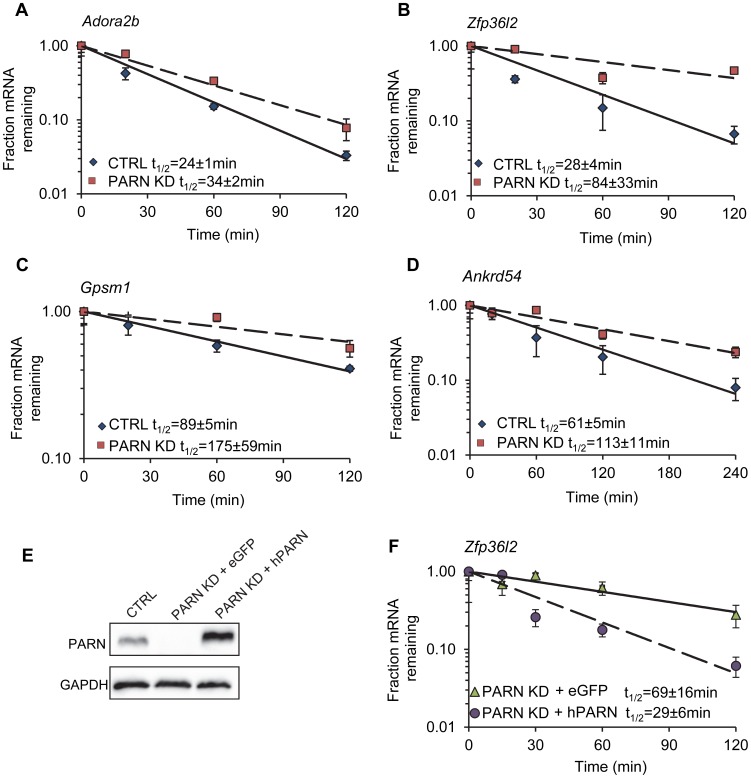
Independent assays validate the changes in decay in PARN KD cells and verify that stabilization is due to PARN depletion.mRNA decay rates for (A) Adora2b, (B) Zfp36l2, (C) Gpsm1 and (D) Ankrd54 were determined following Act-D treatment. mRNA abundance at each time point was assessed by qRT-PCR and normalized to that of Gapdh as a stable reference gene. Error bars represent the standard deviation derived from three independent experiments. Half-lives are reported with the standard error at 95% confidence intervals. (E) PARN KD cells were transfected with a control vector (eGFP) or with a construct encoding human PARN and PARN expression was verified by western blot using anti-PARN antibody with GAPDH as a loading control. (F) mRNA decay rates for Zfp36l2 mRNA were evaluated by qRT-PCR in PARN KD cells expressing eGFP or human PARN. Errors represent the standard deviation. Half-lives are reported with the standard error at 95% confidence intervals.